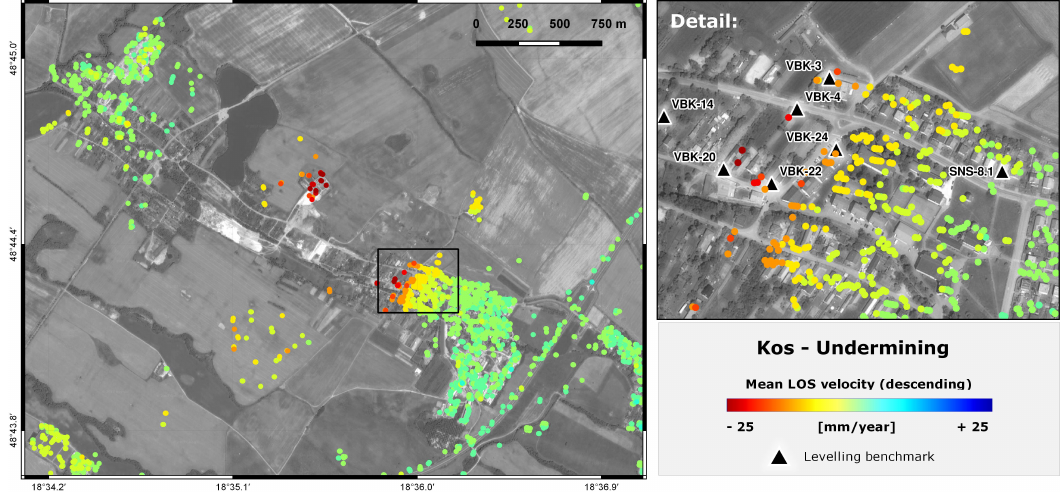
Figure 12. Kos village subsidence due to undermining as observed by MT-InSAR: mean line-of-sight (LOS) deformation velocity map from descending track with detail of area monitored by levelling network. Basemap: Google, 2017